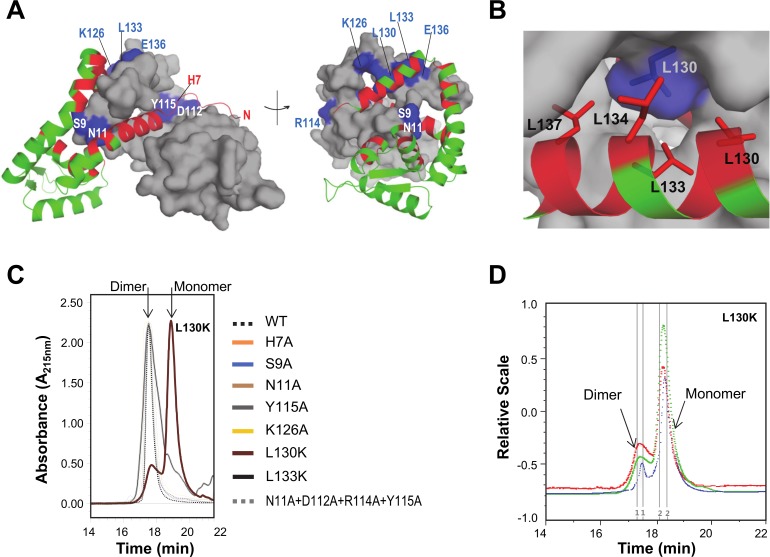
Analysis of the NadR dimer interface.
(A) Both orientations show chain A, green backbone ribbon, colored red to highlight all locations involved in dimerization; namely, inter-chain salt bridges or hydrogen bonds involving Q4, S5, K6, H7, S9, I10, N11, I15, Q16, R18, D36, R43, A46, Q59, C61, Y104, D112, R114, Y115, D116, E119, K126, E136, E141, N145, and the hydrophobic packing interactions involving I10, I12, L14, I15, R18, Y115, I118, L130, L133, L134 and L137. Chain B, grey surface, is marked blue to highlight residues probed by site-directed mutagenesis (E136 only makes a salt bridge with K126, therefore it was sufficient to make the K126A mutation to assess the importance of this ionic interaction; the H7 position is labelled for monomer A, since electron density was lacking for monomer B). (B) A zoom into the environment of helix α6 to show how residue L130 chain B (blue side chain) is a focus of hydrophobic packing interactions with L130, L133, L134 and L137 of chain A (red side chains). (C) SE-HPLC analyses of all mutant forms of NadR are compared with the wild-type (WT) protein. The WT and most of the mutants show a single elution peak with an absorbance maximum at 17.5 min. Only the mutation L130K has a noteworthy effect on the oligomeric state, inducing a second peak with a longer retention time and a second peak maximum at 18.6 min. To a much lesser extent, the L133K mutation also appears to induce a ‘shoulder’ to the main peak, suggesting very weak ability to disrupt the dimer. (D) SE-HPLC/MALLS analyses of the L130K mutant, shows 20% dimer and 80% monomer. The curves plotted correspond to Absorbance Units (mAU) at 280nm wavelength (green), light scattering (red), and refractive index (blue).